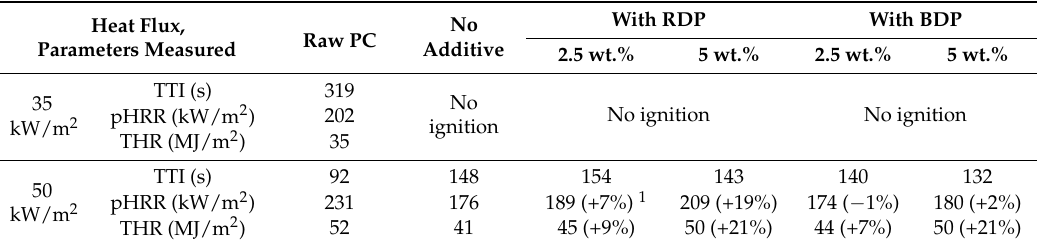
Figure 4. Heat release rate (HRR) curves obtained with uncoated polycarbonate (PC) and coated PC with the self-stratified epoxy/silicone compositions containing ( a ) RDP and ( b ) BDP flame retardant (FR) additives at 2.5 wt.% and 5 wt.%. Table 2. Mass loss calorimeter (MLC) values obtained at 35 and 50 kW/m with uncoated and coated PC with the epoxy/silicone composition with and without FR additives.